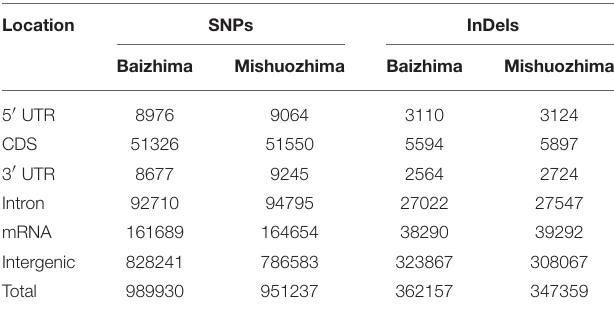
TABLE 4 | Summary of genomic location of SNPs and InDels in “Baizhima” and “Mishuozhima”